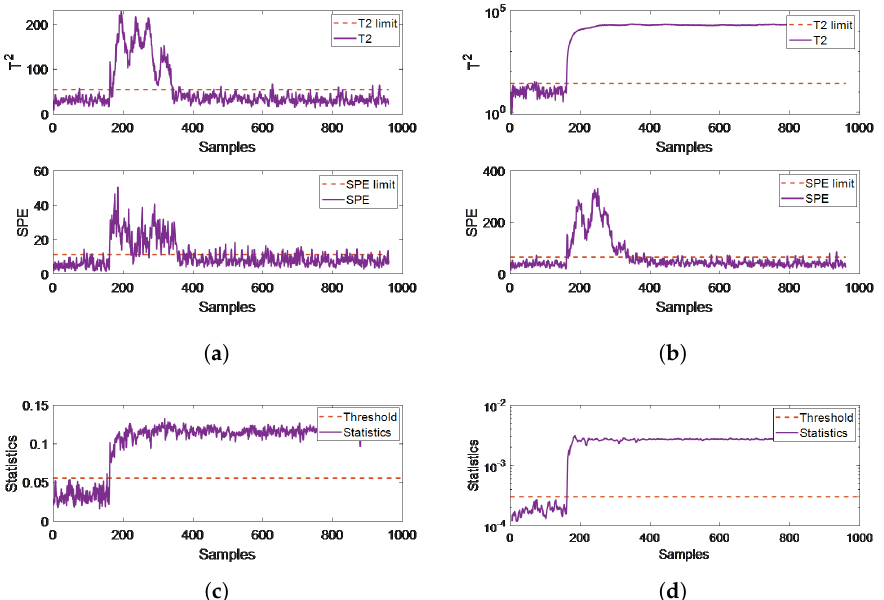
Figure 5. Comparison of detection results for Fault5: ( a ) Fault detection by PCA; ( b ) Fault detection by GLPP; ( c ) Fault detection by SAE; ( d ) Fault detection by DESAE.